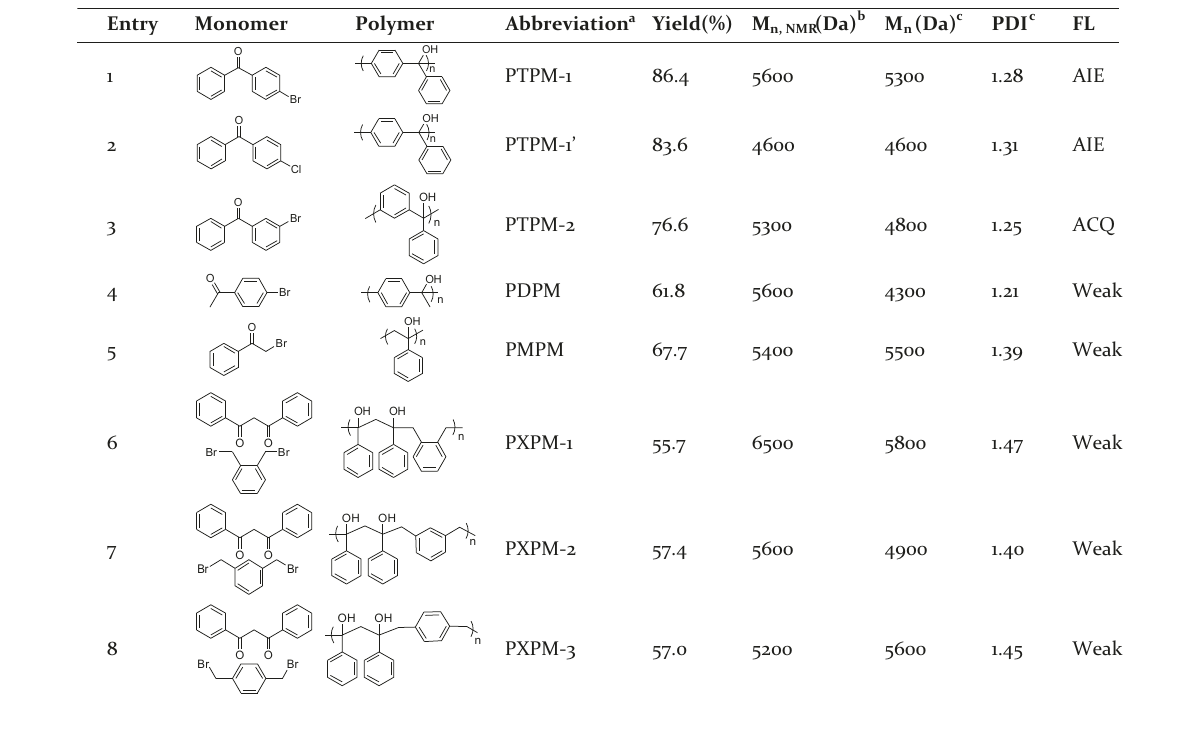
Table 1. From the comparison of 1 H NMR spectra of these monomers and corresponding products (Supplementary Figs. 1 –